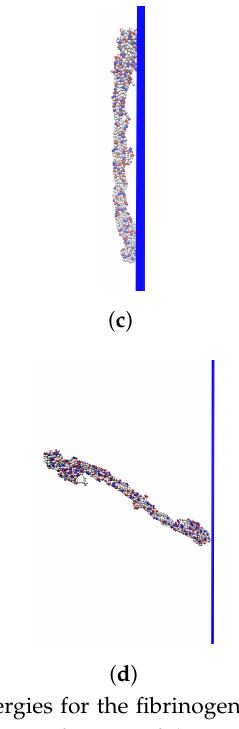
Figure 3. ( a ) The adsorption free energies for the fibrinogen main body to surfaces with different surface charge densities. ( b ) Distribution of cosine of the angle between the surface normal and an adsorbed protein for the higher surface charge densities. (The upper limit of the y -axis has been set so that it is possible to view peaks other than the ones for small cosine.) ( c ) A configuration with cosine close to 0, corresponding to the deepest free energy well when the surface charge is 0.01 e /Å 2 . ( d ) A configuration with high cosine, corresponding to the second free energy well when the surface charge is 0.01 e /Å 2